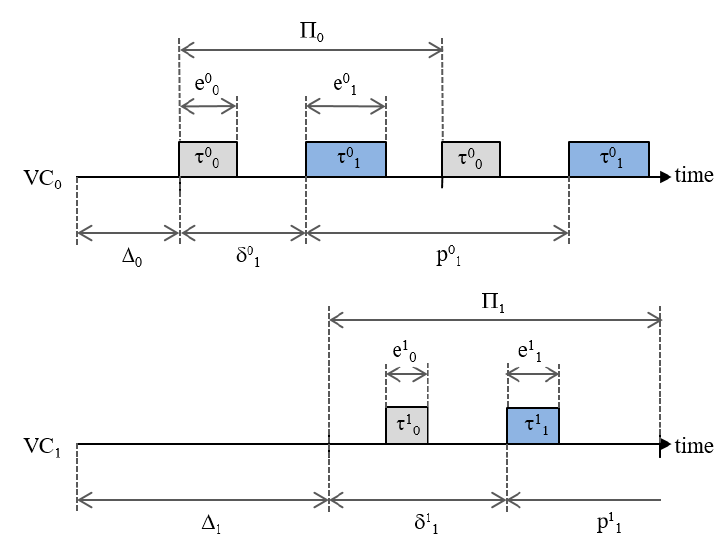
Figure 5. Hierarchical real-time